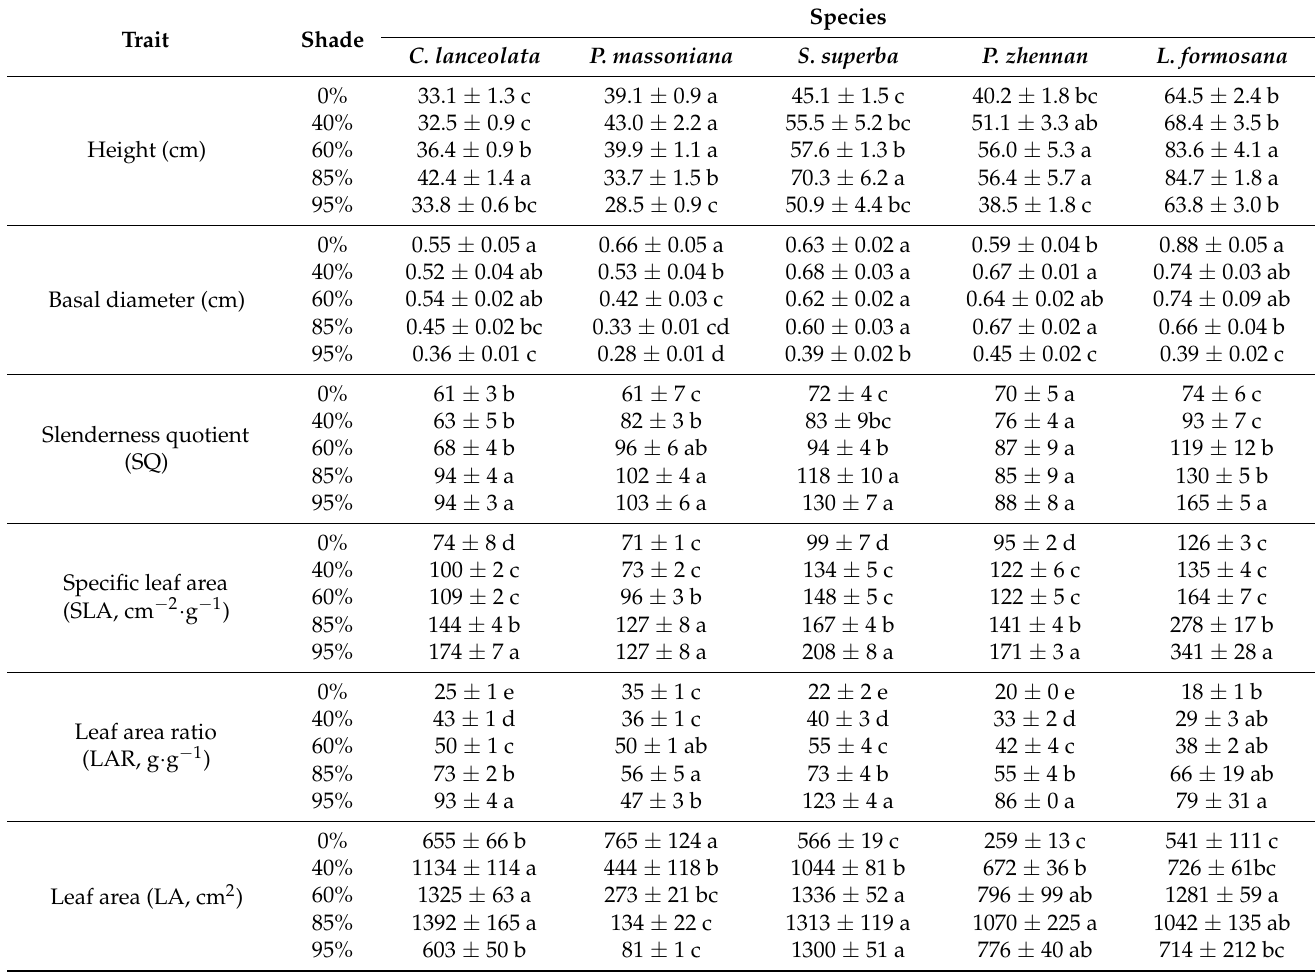
Table 2. Seedling morphology characteristics of five tree species under different shade treatments.